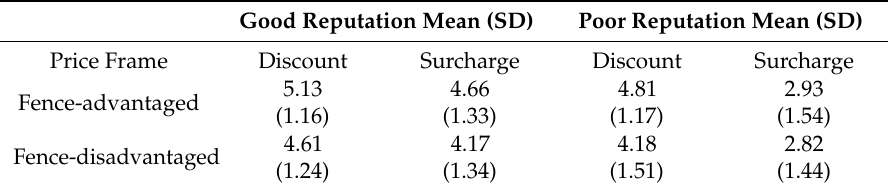
Table 2. The mean score of fairness perceptions.